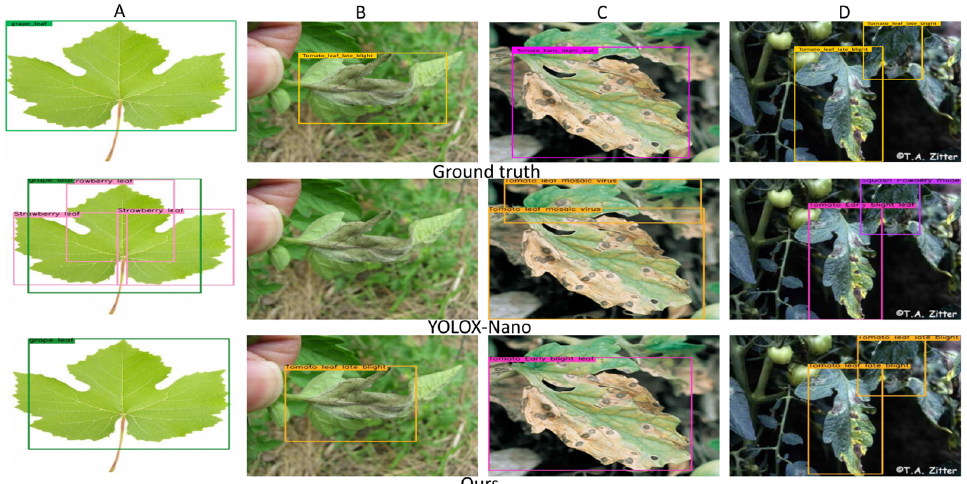
Figure 9. Visualization of detection results for different scenarios of the PlantDoc. A: Simple scenes; B: Small target scenes; C: Complex scenes; D: Multi-target scenes.